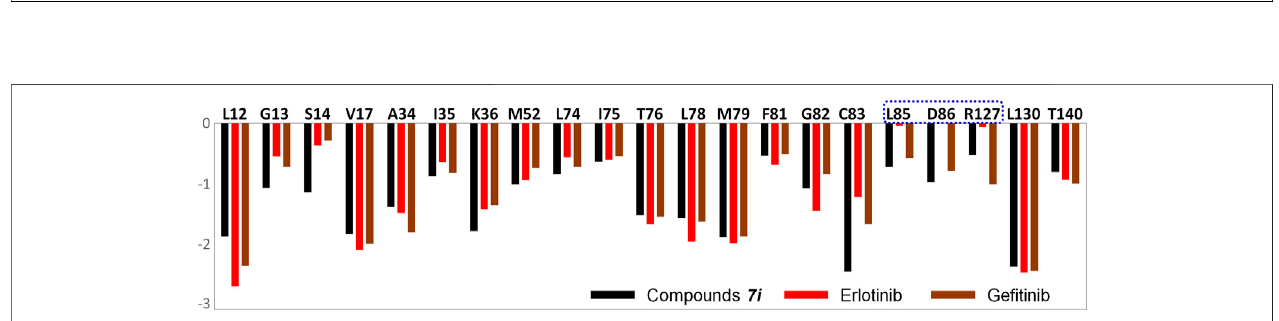
FIGURE 7 | Per-residue binding free energy decomposition of all the studied systems: the residues with energy contribution (absolute value ≥ 0.1) are selected.